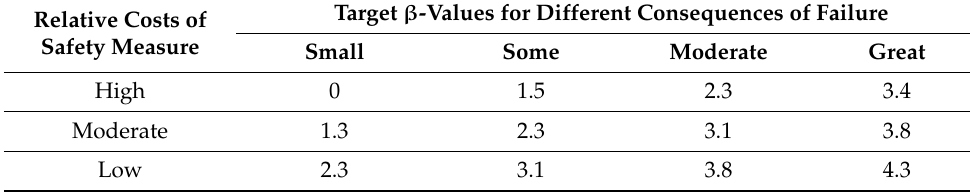
Table 2. Target β -values for elements (lifetime), ISO 2394: